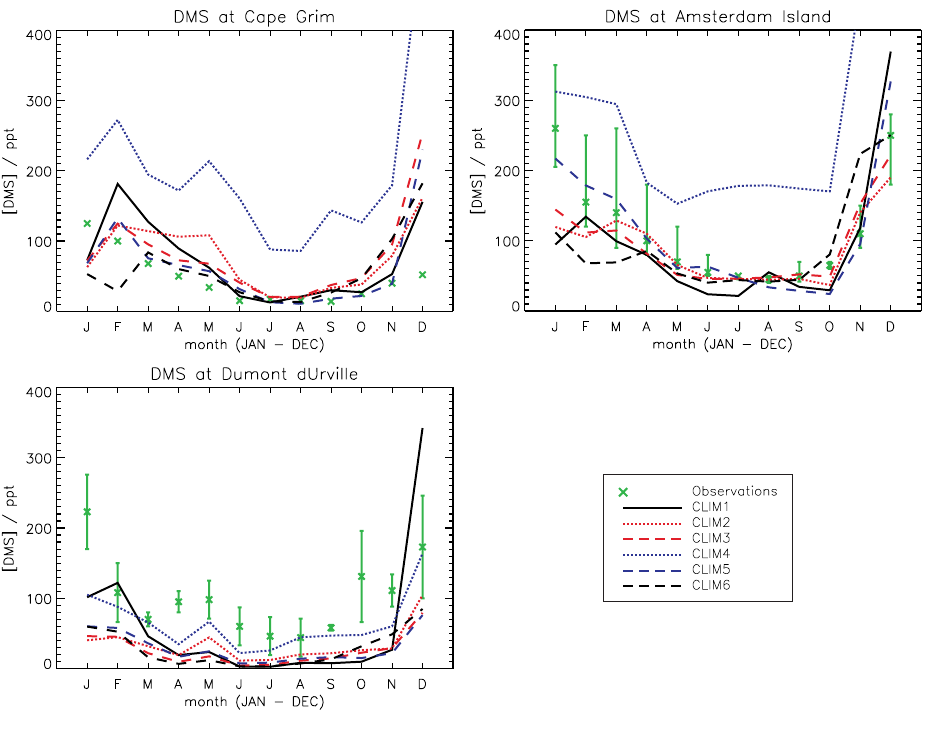
Fig. 5. Predicted atmospheric DMS concentrations from the five present day climatologies, plotted against monthly averaged observations from three sites, Cape Grim, Amsterdam Island and Dumont d’Urville. Observations show error bars where known (Amsterdam Island: 5th and 95th percentiles; Dumont d’Urville: ±1 standard deviation).